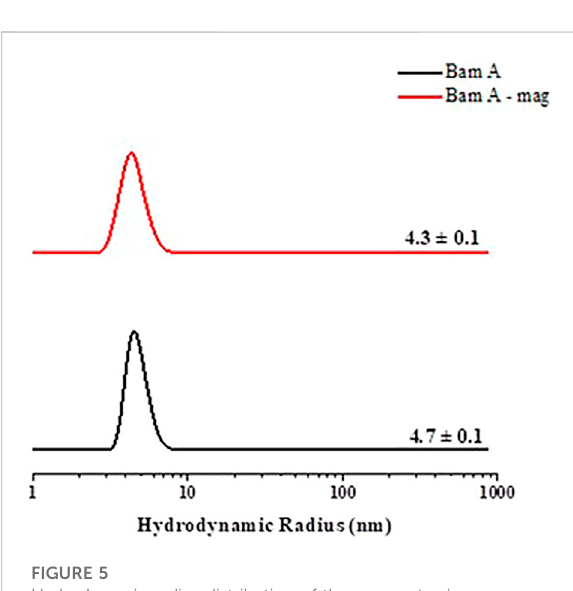
FIGURE 5 Hydrodynamic radius distribution of the aggregates in